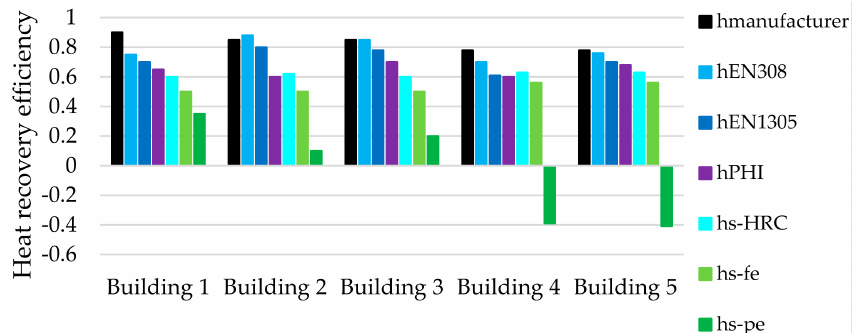
Figure 17. Preference results of different decision makers for evaluation indexes [170]; where: η η EN308 —efficiency calculated in accordance with manufacturer —efficiency given by the manufacturer; EN-308 [171]; η EN1305 —efficiency calculated in accordance with EN-13053 [172]; η PHI —efficiency calculated according to the Passivhaus test procedure; η s-HRC —efficiency as a ratio of the reduction of heat demand to the reference heat demand; η s-fe —final energy seasonal yield; η s-fe —seasonal primary energy